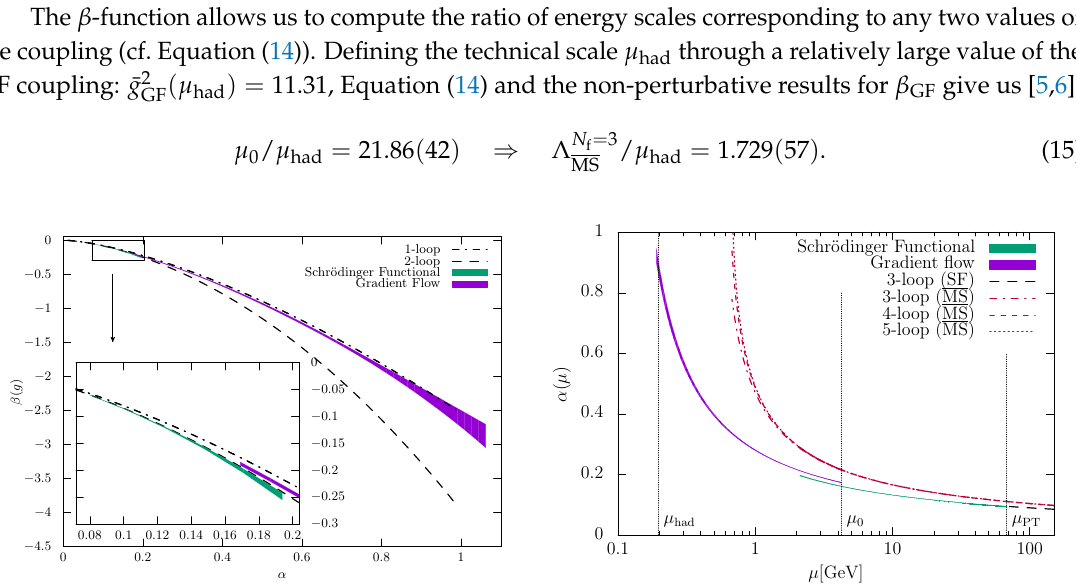
by integrating MS